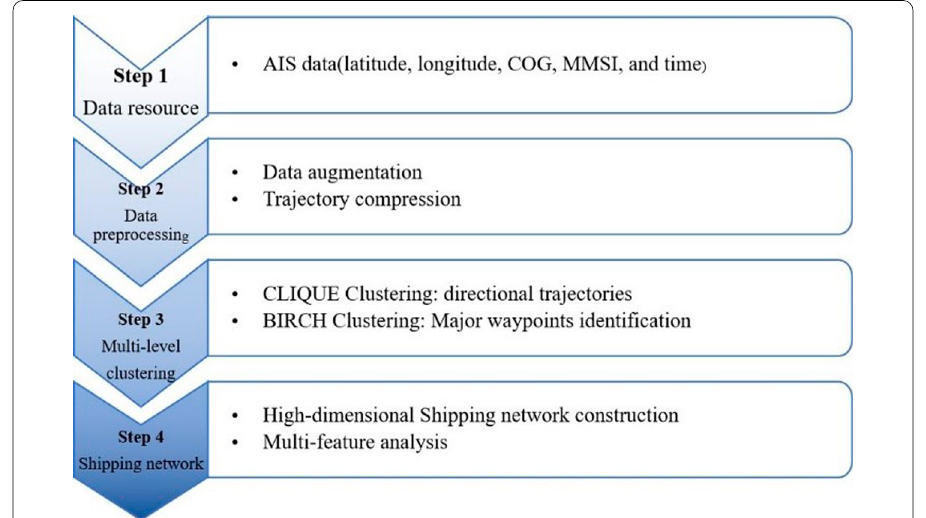
Fig. 1 Methodological overview of the